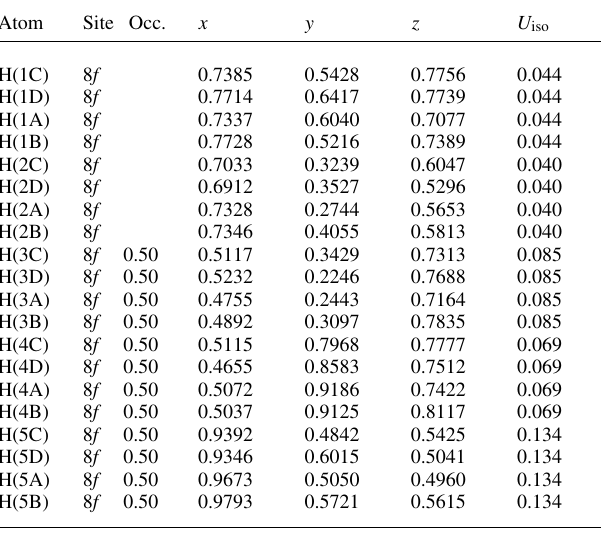
Table 2. Atomic coordinates and displacement parameters (in Å 2 )